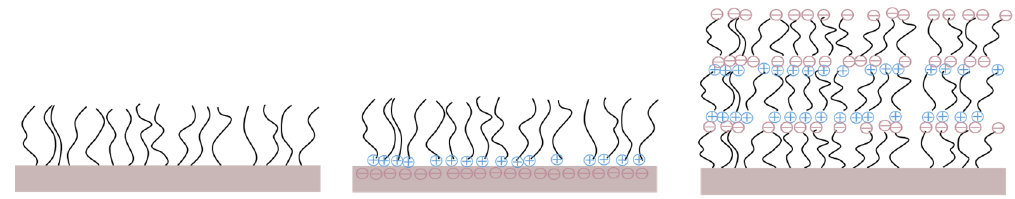
Figure 4. Various assemblies of polysaccharides onto a substrate .